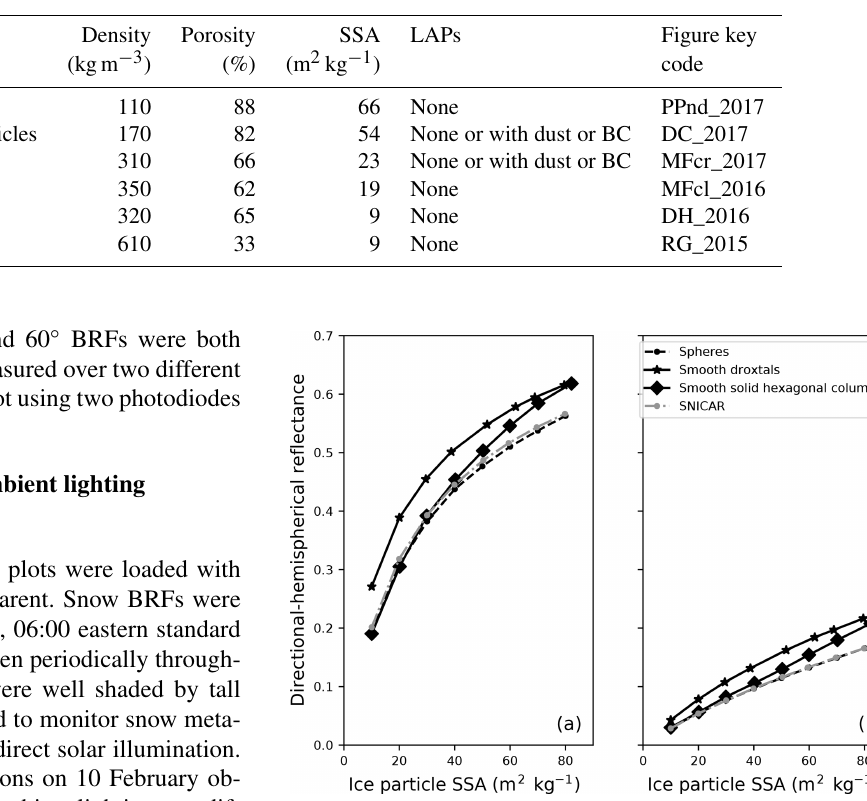
Figure 3. Modeled 1.30µm nadir (a) and 1.55µm 15 ◦ directional hemispherical reflectance (b) for various snow SSA. Solid line seg- ments connect albedo calculations from Monte Carlo simulations of light scattering in snow media comprised of droxtals (stars) and solid hexagonal columns (diamonds). Circles connected by dashed or dotted line segments connect snow albedo calculations modeled as spherical ice particles from Monte Carlo modeling (black) and from the Snow, Ice, and Aerosol Radiation (SNICAR) online model